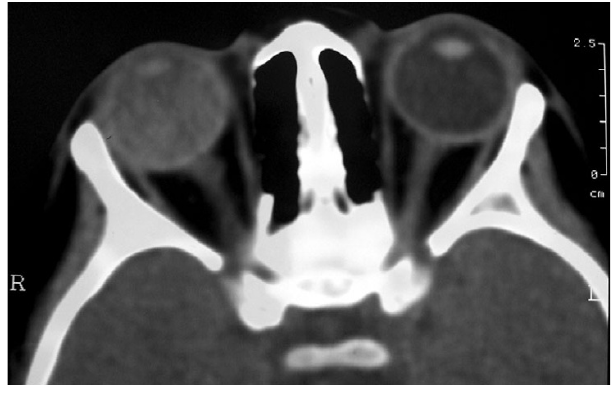
Computed Tomography Figure